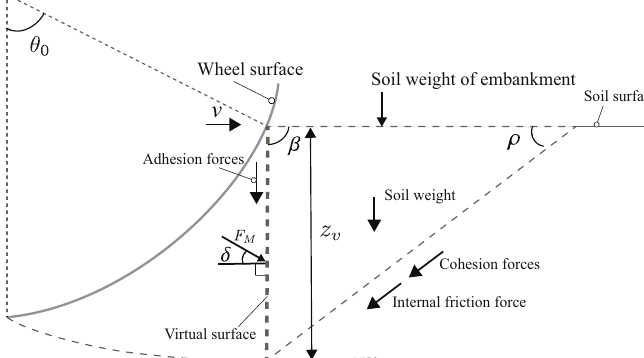
Figure 17. Plate failure plane geometry and variables for force F 1 . The horizontal component of F M is assumed that the force F 1 from area B . The soil wedge beneath the wheel is assumed to move together with the wheel. The surface between soil wedge areas A and B is assumed as a virtual surface (the length z v